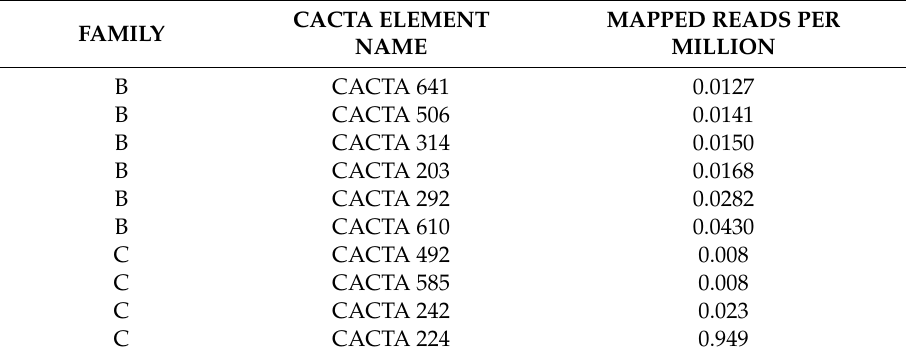
Table 3. Expressed transposase (TPase) domains of CACTA elements. The expression is reported in mapped reads per million, and for each element, the family is reported.